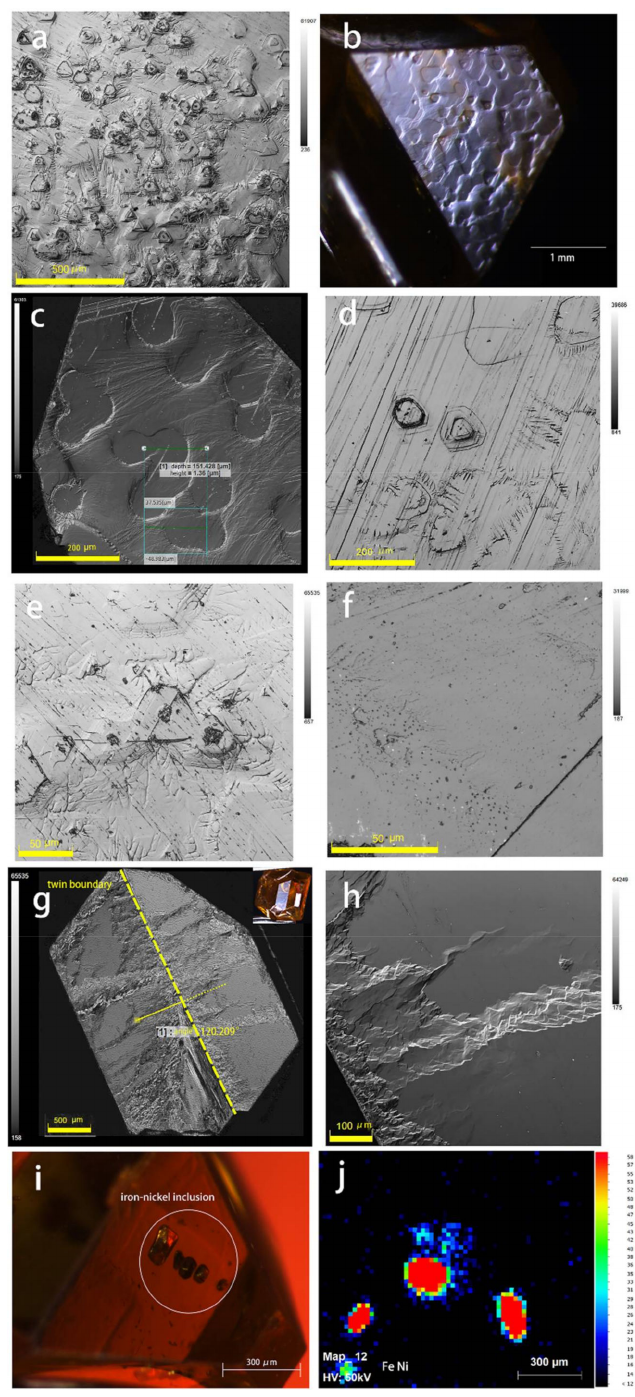
Figure 5. Etch figures of the HPHT-grown diamond crystals with contact twinning observed by 3D Laser Confocal Microscopy ( a – h ); ( a ) many kinds of etch pits on crystal plane in TW-07; ( b ) etch pits forms the fish-scale pattern in TW-02; ( c ) circular pits on crystal plane in TW-02; ( d , e ) some etch pits show that point-bottomed origins in TW-02 and TW-07; ( f ) a large number of dense, tiny triangles distributed on the {111} plane in TW-04; ( g , h ) the vein-like pattern on both sides of the twin boundary in TW-01; ( i , j ) the Fe-Ni inclusion in TW-09 and distribution of Fe-Ni elements in micro-XRF